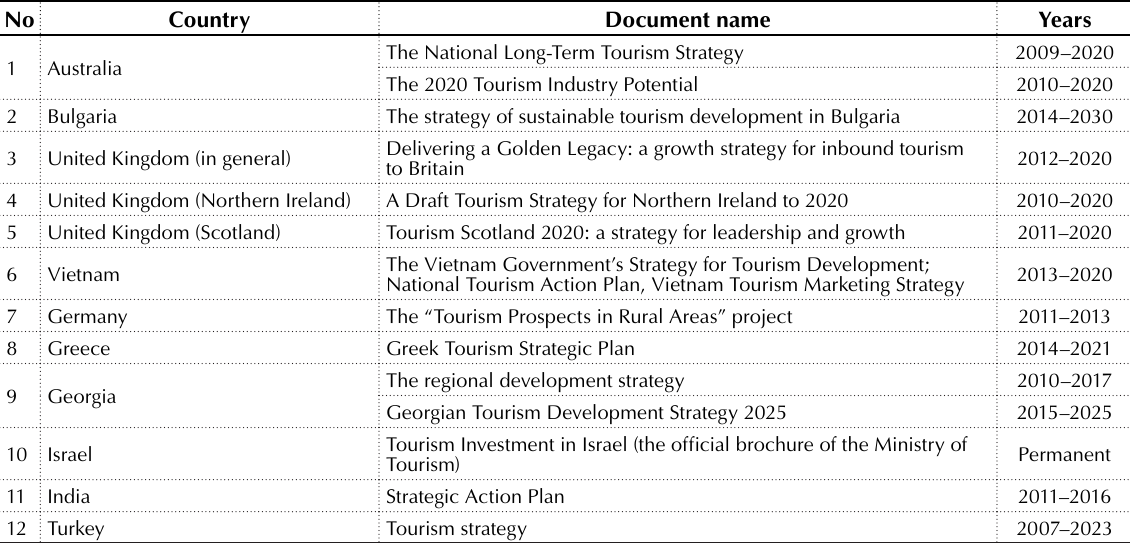
Table 5. The analysis of state programs and investment